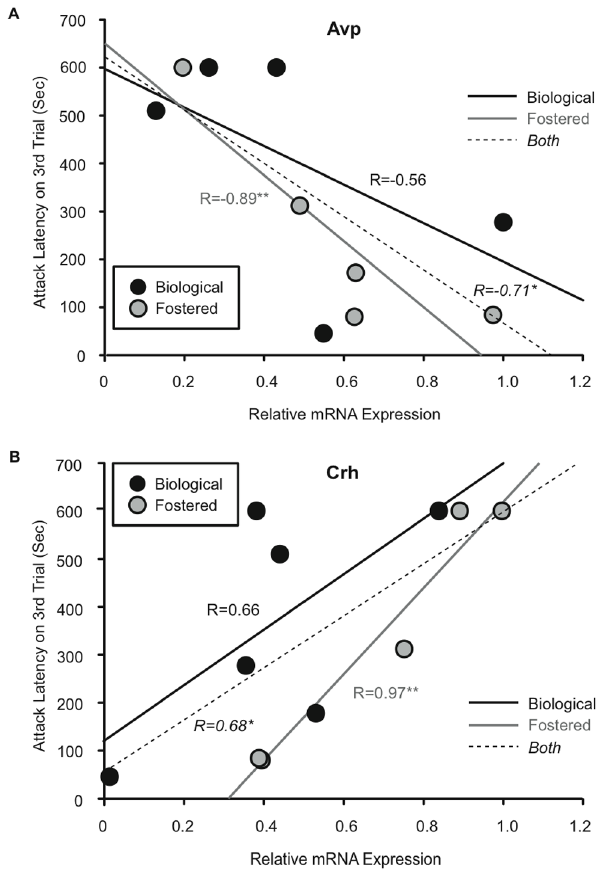
Figure 4. Amygdala gene transcription is altered in fostered B6 male offspring. Scatter plots with best-fit regression lines showing correlations between relative gene expression and latency to attack in the third aggression test of biological (n=5) or fostered (n=6) male B6 offspring. (A) * Attack latency correlated negatively with Avp mRNA transcription (r=–0.71, p , 0.03; dashed line). ** When separated by group, attack latency correlated negatively with Avp mRNA transcrip- tion in fostered (r= –0.89, p , 0.05; gray solid line) but not biological (r=–0.56, p=0.33; black solid line) offspring. (B) * Attack latency correlated positively with Crh mRNA transcription (r=0.68, p , 0.03; dashed line). ** When separated by group, attack latency correlated positively with Crh mRNA transcription in fostered (r=0.97, p , 0.005; gray solid line) but not biological (r=0.66, p=0.15; black solid line) offspring.